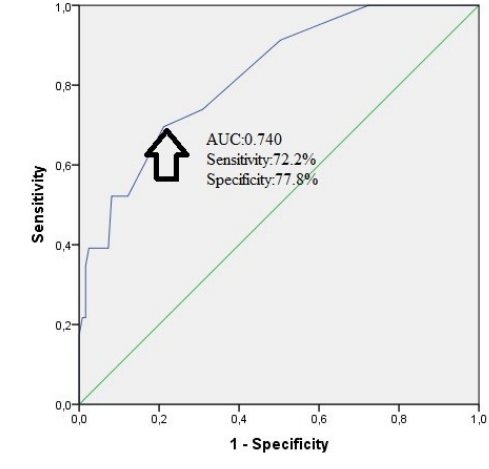
Fig. 1 - Receiver operating characteristic (ROC) curve for immature granulocytes for predicting mortality in ST-segment elevation myocardial